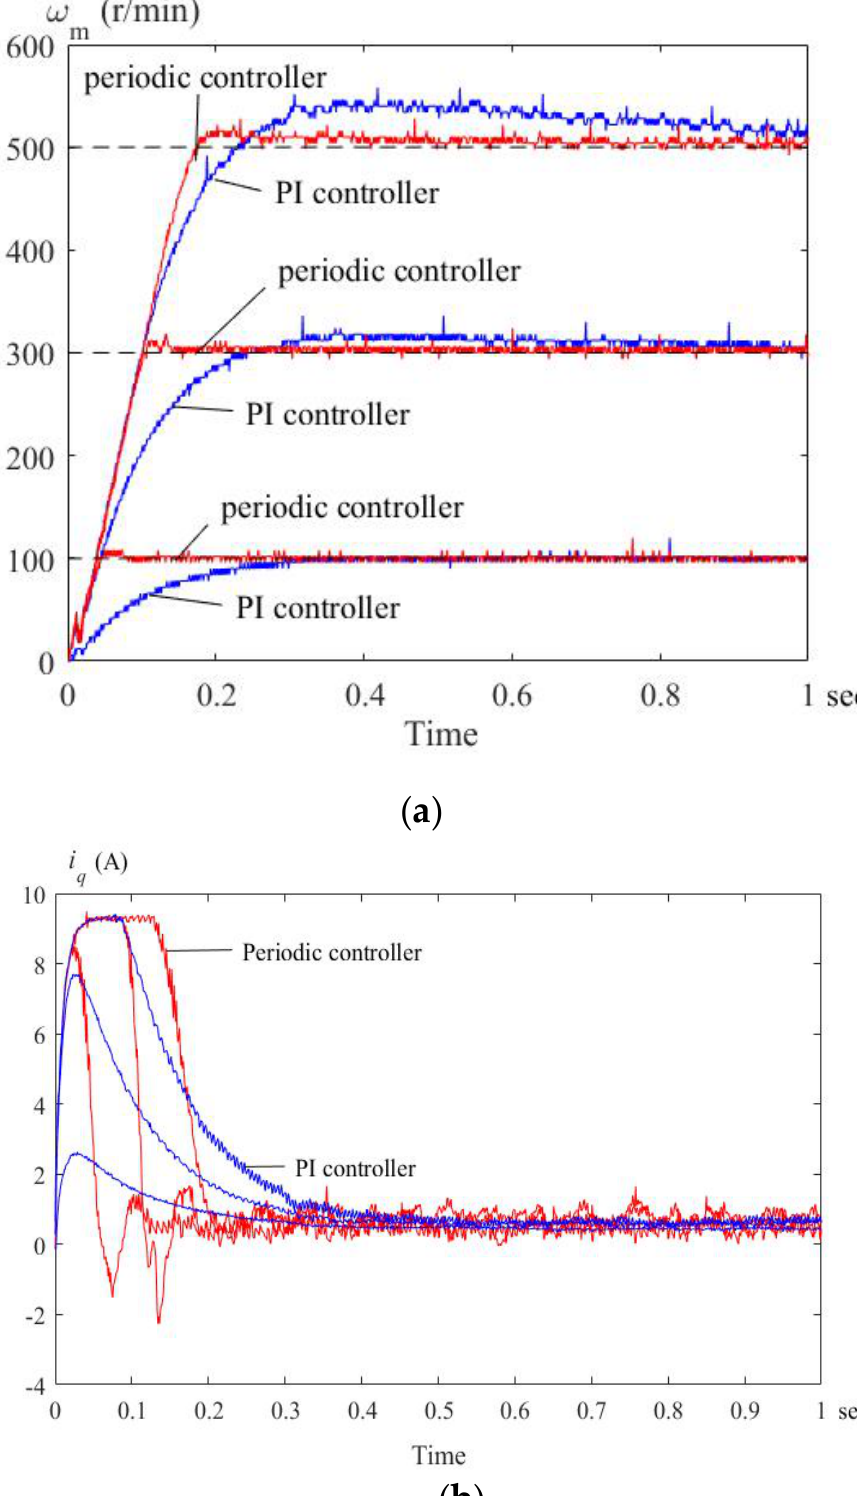
Figure 10. Measured speeds at 100 r/min, 300 r/min, and 500 r/min: ( a ) speed responses; ( b ) q -axis currents.